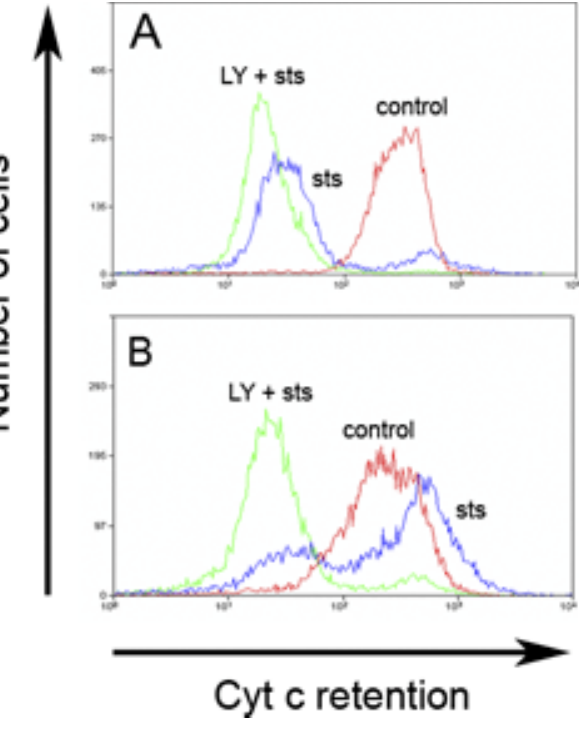
Figure 2. Cytochrome c Release from C. trachomatis -Infected Cells Treated with the PI3K Inhibitor Cells were infected with C. trachomatis at an MOI of 1.0 for 26 h (B) or mock-infected (A), and then incubated with control buffer or 50 l M LY294002 (LY) or control buffer for 6 h before treating with 2 l M STS overnight. Cells were then collected for cytofluorimetry, permeabilized with detergent, and incubated with anti-cytochrome c antibody, as described in Materials and Methods. Cytochrome c was released from uninfected cells that were treated with STS (A), but was retained in infected cells treated with STS (B). However, cytochrome c was released in infected cells that had been pre-incubated with LY294002 before STS treatment (B). One experiment of two representative experiments performed on separate days is shown. DOI: